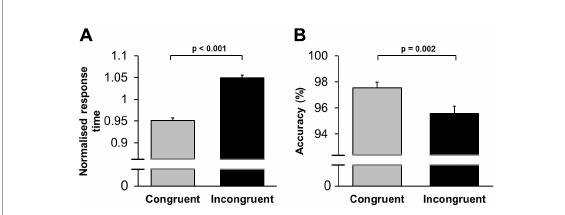
FIGURE3 Conflict-induced behavioural adjustment in the Stroop test. (A) Mean normalised response time is shown for congruent and incongruent trials. Response time was significantly shorter in low conflict (congruent trials), compared to high conflict (incongruent trials). (B) The mean percentage of correct responses (accuracy) is shown for congruent and incongruent trials. Accuracy was significantly higher in congruent trials compared to incongruent trials. Error bars represent standard error of the mean (SEM).